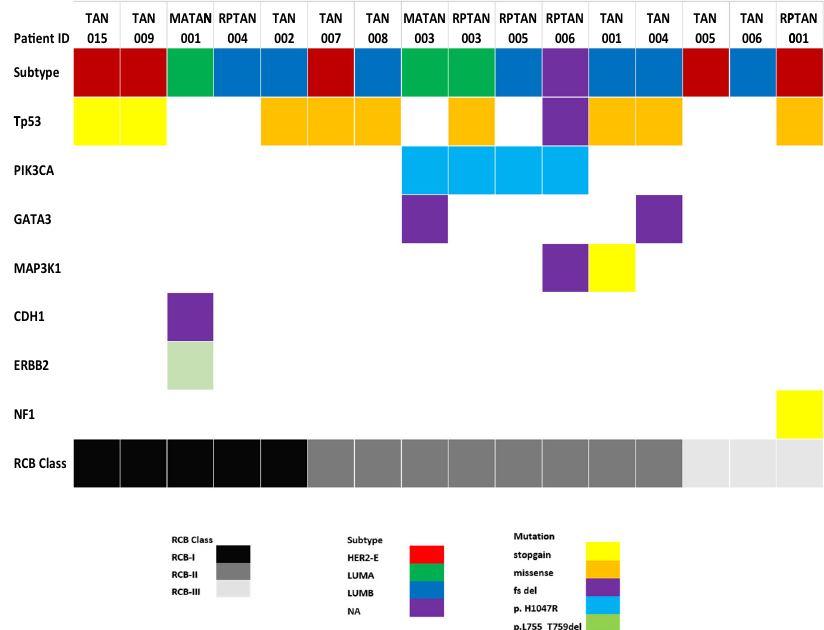
Fig. 4 Tumor somatic mutations by WES occurring in at least three patient samples according to pathological status. The vertical axis represents the patient ID, tumor molecular subtype, and genes with somatic mutations. Each column represents a unique patient ’ s sample.